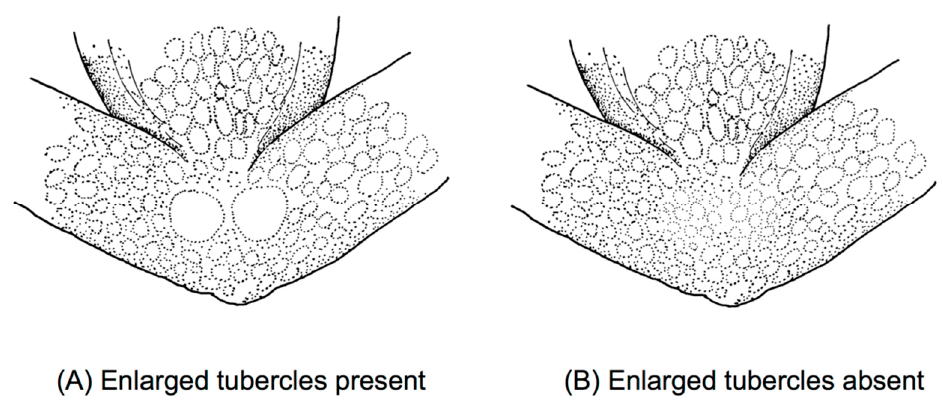
Figure 15. Ventral surfaces of tights in glassfrogs. ( A ) With enlarged subcloacal warts. ( B ) Lacking enlarged warts. Illustrations by Juan M. Guayasamin.